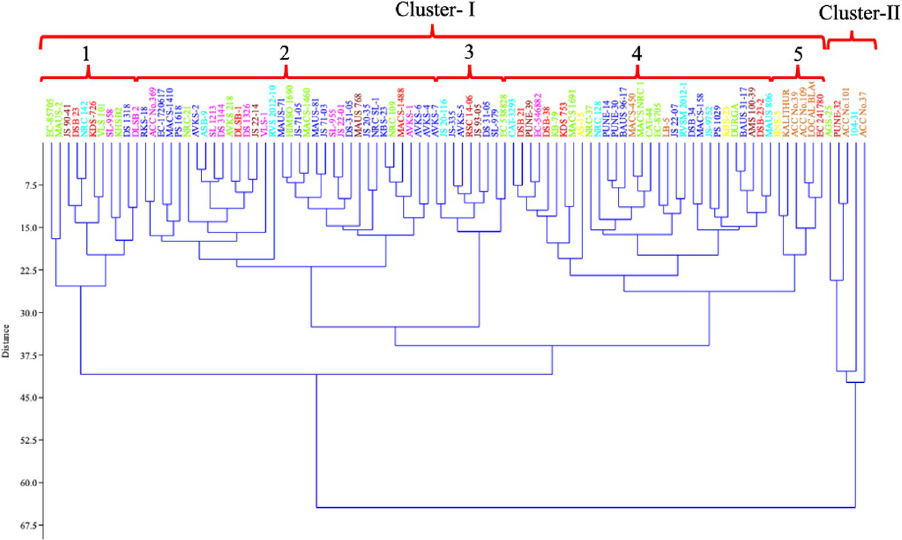
Fig 11. UPGMA based hierarchical clustering of genotypes using quantitative and qualitative traits.